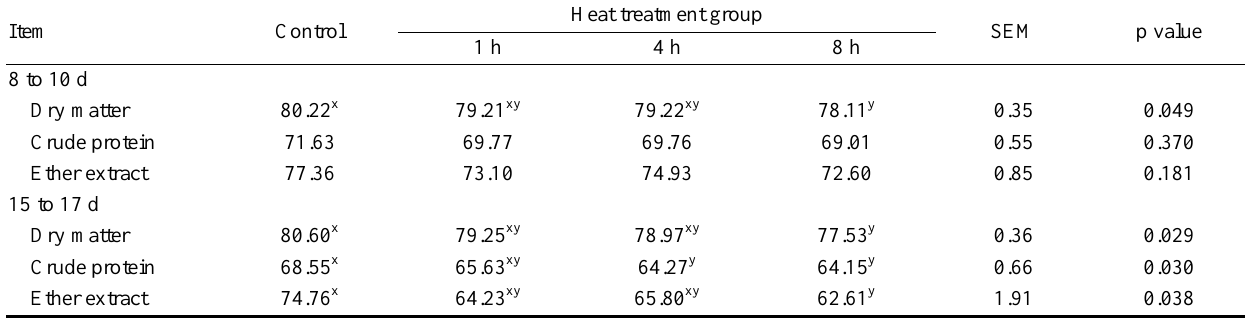
Table 6. Effects of heat-oxidized soy protein isolate on apparent nutrient digestibility of broilers (%)